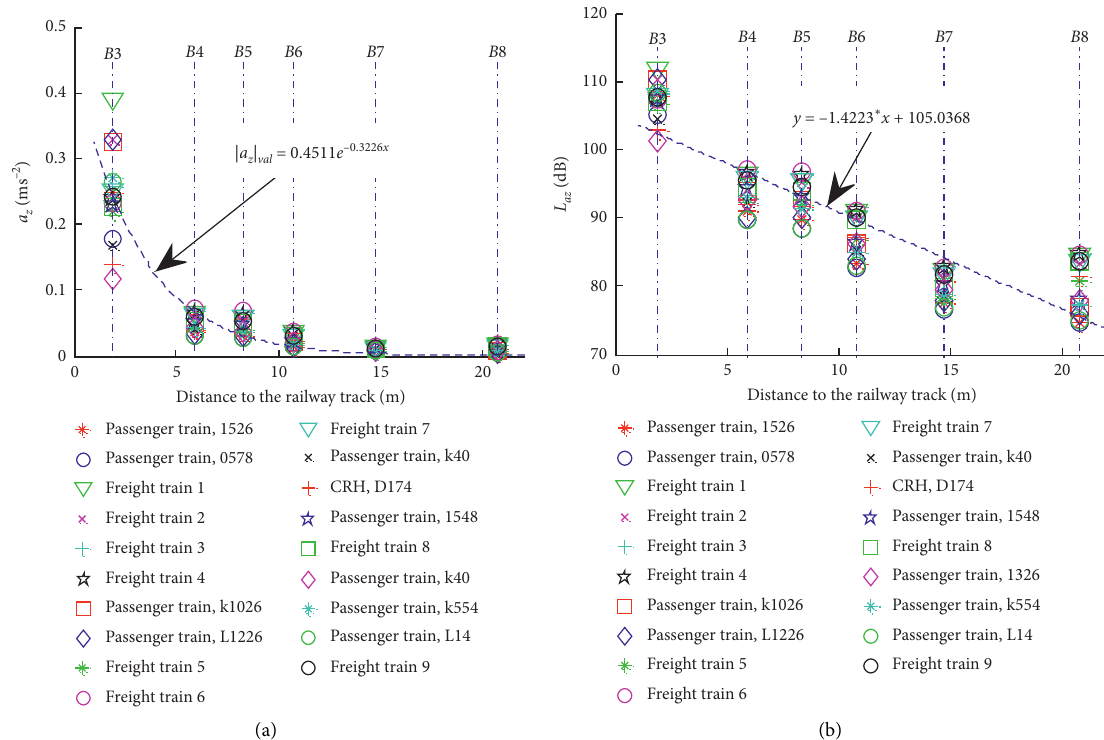
Figure 5: Fitting curve of the vibration level attenuation mechanism in the frozen period: (a) effective value of acceleration and (b) acceleration level.